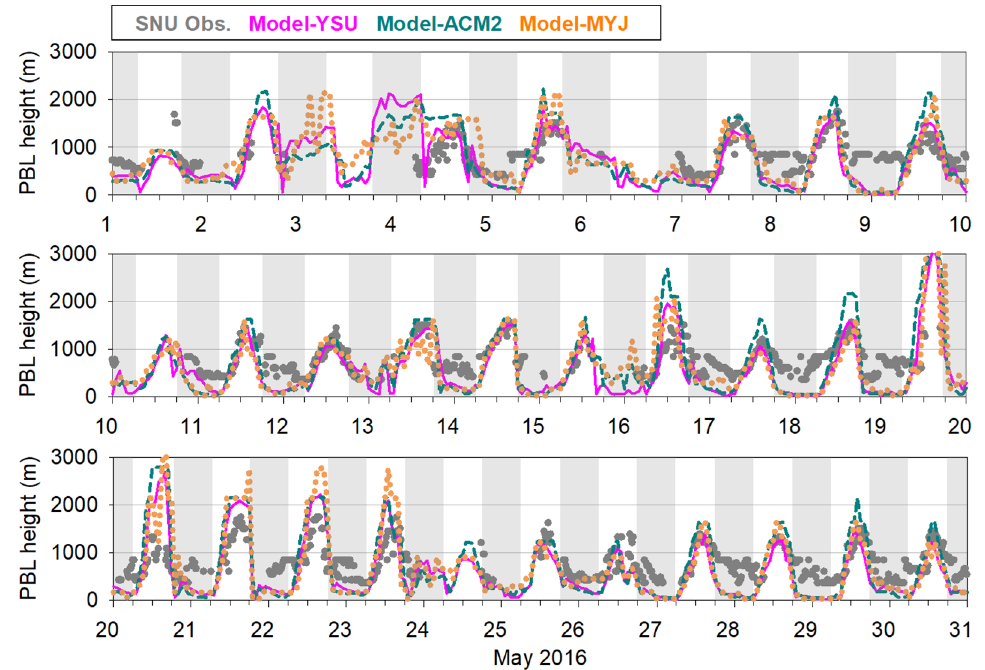
Figure 4. Comparison of PBLH between observations at P1 (Gwanak; gray) and simulated values obtained using the YSU (pink), ACM2 (blue), and MYJ (orange) parameterization schemes in the WRF-Chem model. Gray shaded area indicates nighttime (21:00–6:00 LST).